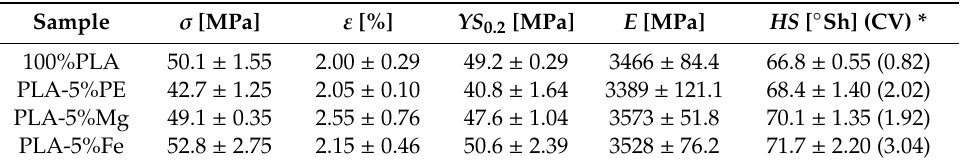
Figure 3. Typical curves of the tensile tested composite materials. Table 1. Summarized results of tensile tests and hardness of the tested composite samples.